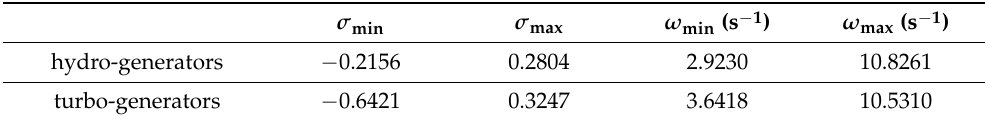
Table 5. The boundaries of real and imaginary parts of local mode eigenvalues of hydro and turbo synchronous generators with AVR systems of different nominal powers in the range P = 0.0 pu to P = 1.2 pu and from Q = 0.0 pu to Q = 1.2 pu. σ min σ max ω min (s − 1 ) ω max (s − 1 ) hydro-generators − 0.2156 0.2804